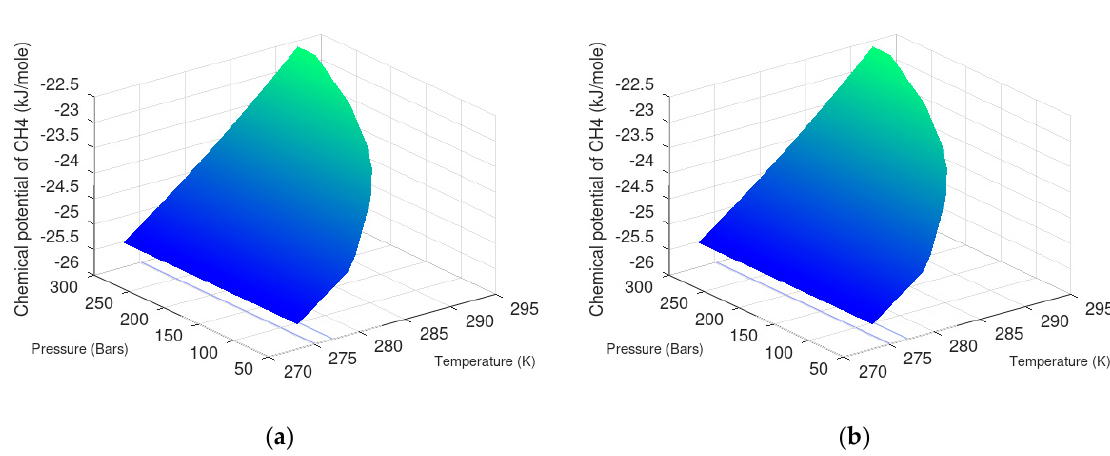
Figure 10. Chemical potential of CH 4 entering hydrate as function of temperature pressure and mole-fractions CH 4 (see Figure 10) for: ( a ) 0 ethanol and ( b ) 3 mole percent ethanol in water.